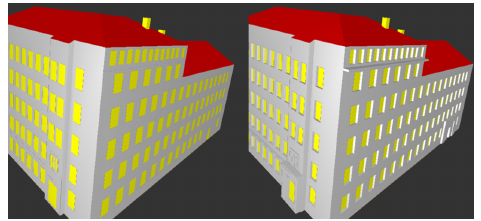
Figure 3. Model simplifications of a LoD3 model